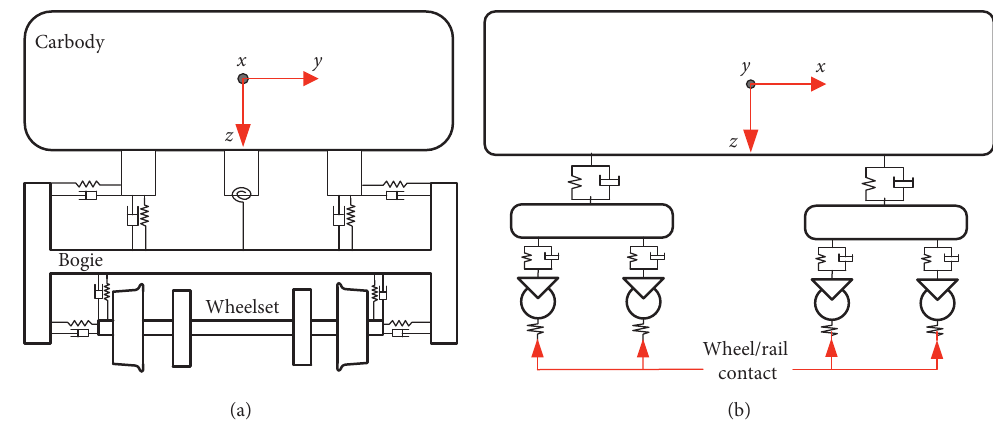
Figure 2: A schematic of vehicle dynamic model.